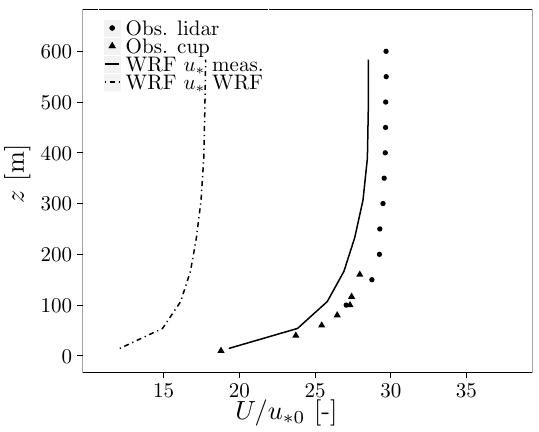
Figure 4. Comparison of the prediction of the wind speed from the simulation by the WRF model and measurements from the wind lidar at 600m.